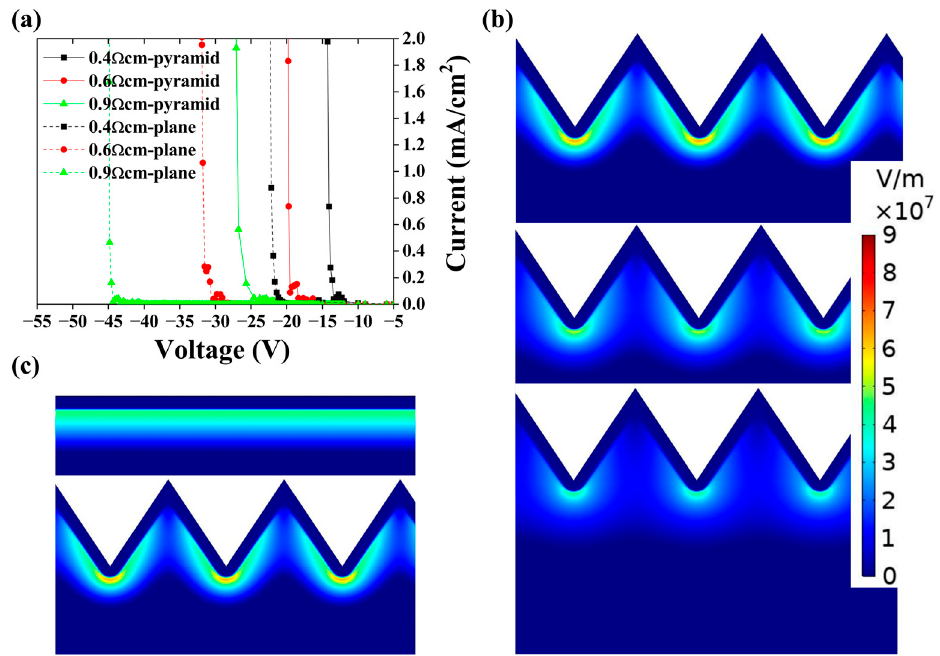
Figure 5. ( a ) Simulation results for the reverse I–V curves for different resistivities and texture structures at high doping; the solid lines and dotted lines represent the pyramid-textured surface and the planar surface of the cells, respectively; ( b ) simulated electric field distribution diagrams for a high-doping pyramid surface and a substrate resistivity of 0.4 Ω cm ( top ), 0.6 Ω cm ( middle ), and 0.9 Ω cm ( bottom ) under a − 14 V reverse bias; ( c ) simulated electric field distribution for high doping at a − 14 V reverse bias and a 0.4 Ω cm resistivity under the planar structure ( top ) and pyramid structure ( bottom ).